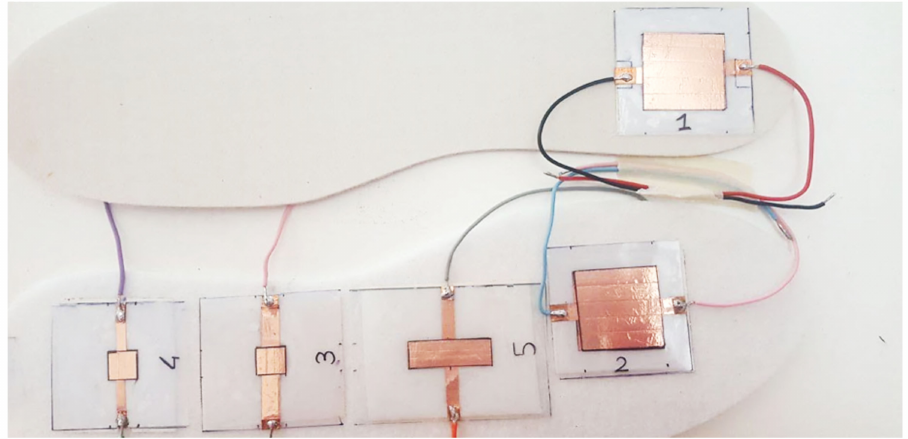
Figure 15. Piezoresistive sensors realized with different sizes and shapes placed on a felt